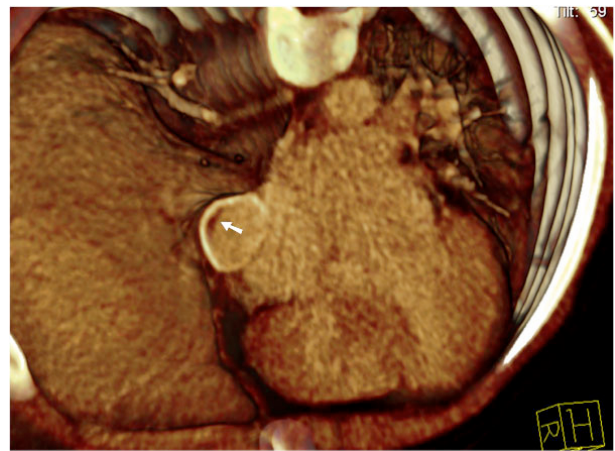
Fig.3A - Material deposited in the extracardiac conduit - Chest angiotomography image (short axis) performed 6 months after total cavopulmonary connection with extracardiac conduit. Short axis cuts